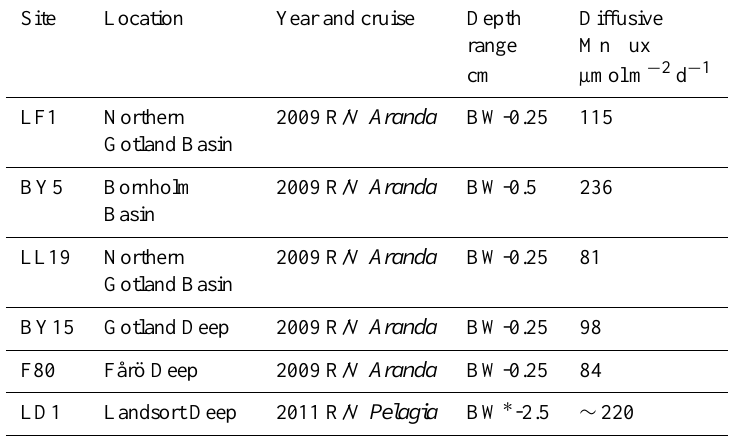
Table 2. Diffusive fluxes of Mn across the sediment–water interface at all six sites. For further details, see text. For the bottom water and pore water data, see Supplement